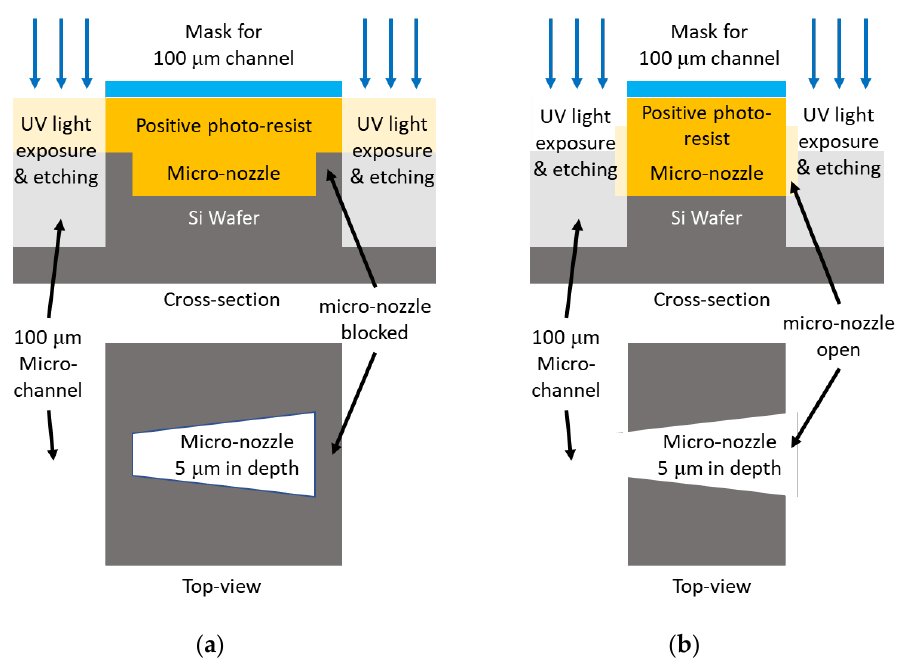
Figure 6. Schematic for ( a ) micro-nozzle blocked due to misalignment of mask and ( b ) design for second mask.